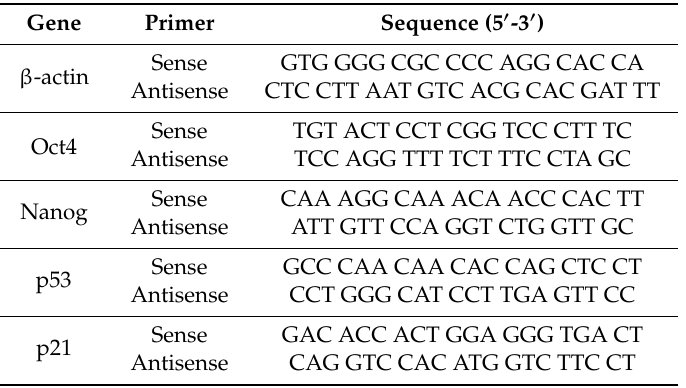
Table 1. List of primers for